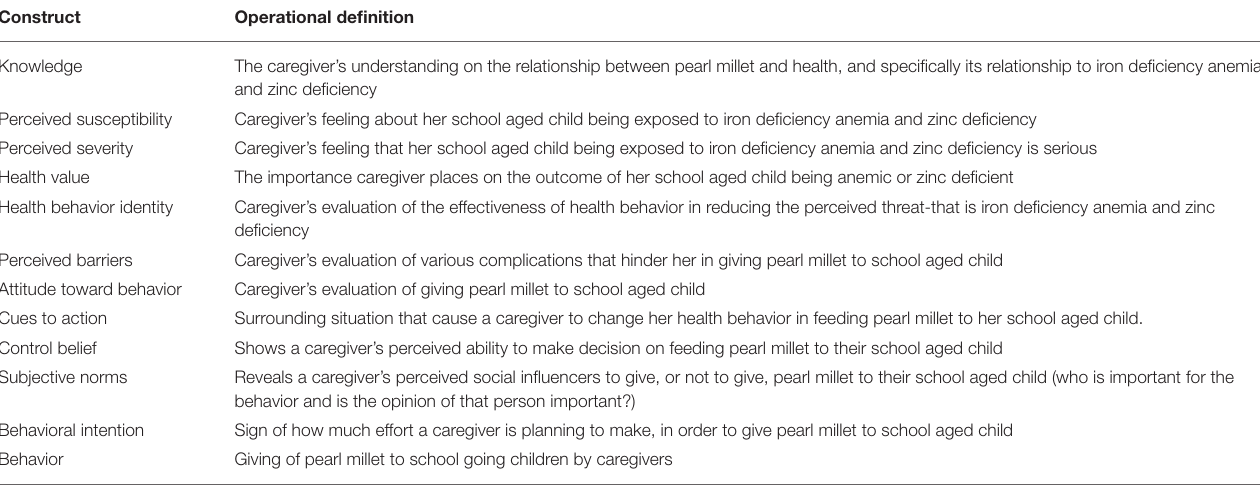
TABLE 1 | Functioning explanation of constructs used to examine internal and external factors predicting intention of caregivers to give pearl millet to school aged children. Construct Operational